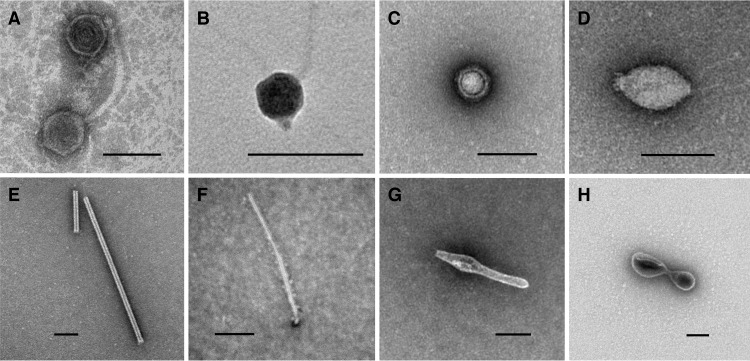
Morphologies of viruses observed in basalt-hosted crustal fluid. (A to H) Electron micrographs of particles harvested from borehole U1362A revealed tailed viruses similar to members of the order Caudovirales (A and B), untailed viruses (C), lemon-shaped viruses resembling members of the family Bicaudaviridae or Fuselloviridae (D), rod-shaped viruses resembling members of the family Rudiviridae (E), and other particles resembling filamentous (F) or spindle-shaped (G) viruses isolated from Archaea. Bilobate structures in the viral size range (H) were repeatedly observed, but they were unlike any classified viruses. These might represent a novel virus or may be membrane vesicles. Bars, 100 nm.